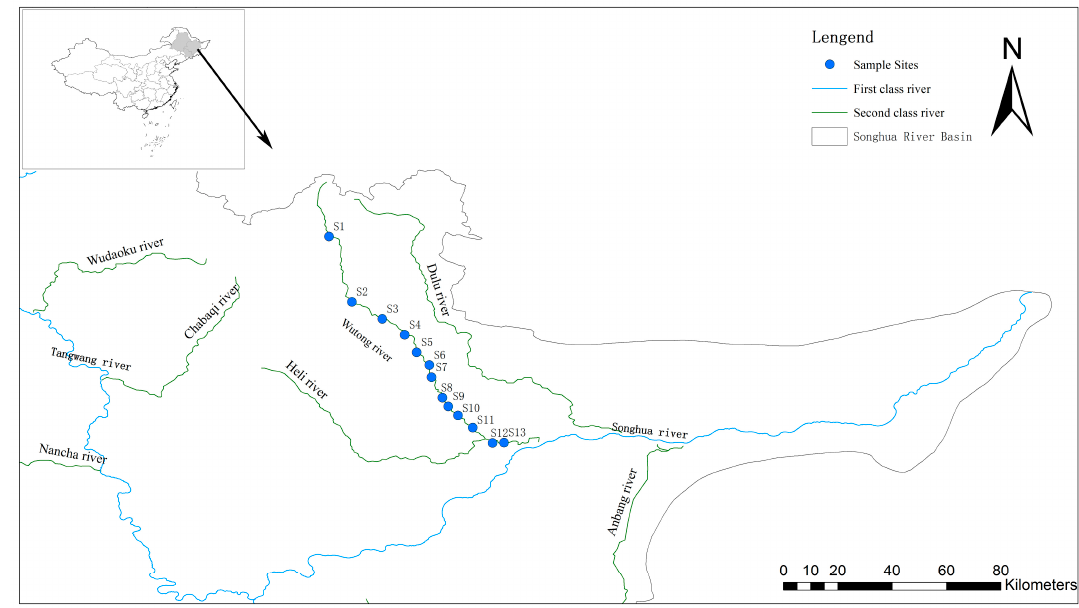
Figure 1. Sampling sites in Wutong